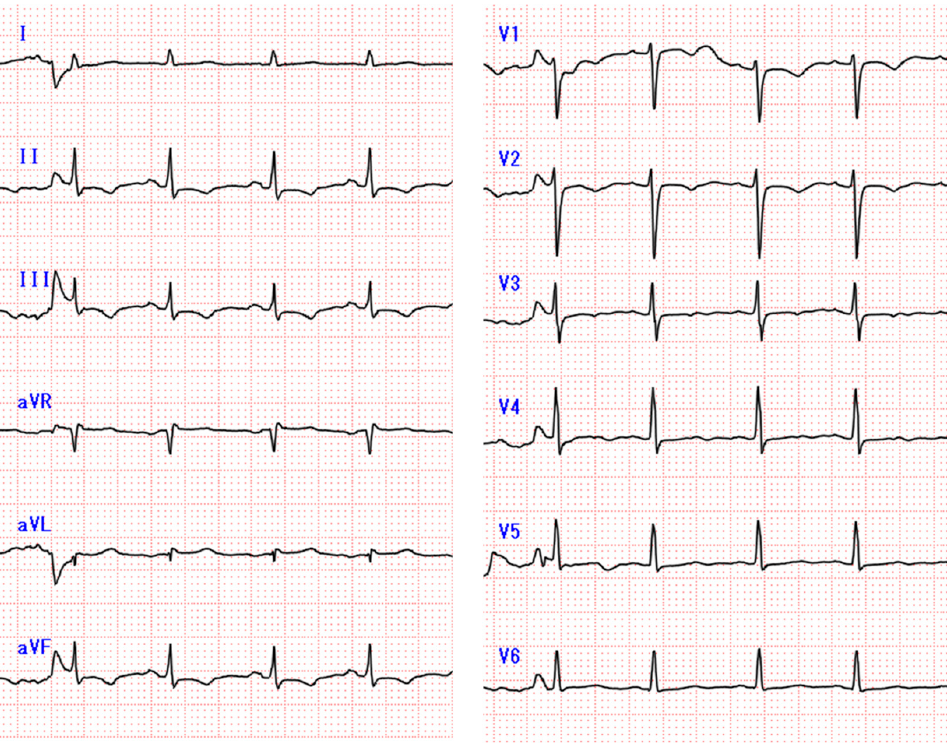
Figure 3. 24-h holter monitoring. ST depression and negative T waves with tachycardia were recorded via 24-h holter monitoring; this was concurrent with the patient’s report of exacerbated fatigue.